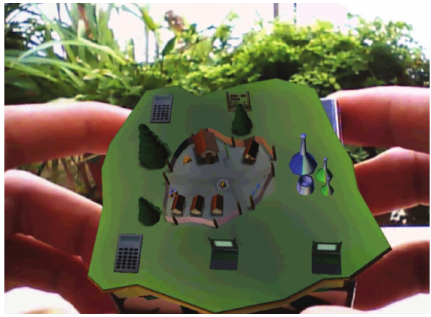
Figure 2: Shu ffl ing the cube shu ffl es the assets arranged around the village accordingly. Here, shu ffl ing the right side of the cube will cause the laptop and the lab assets to be replaced with other assets depending on the cube new